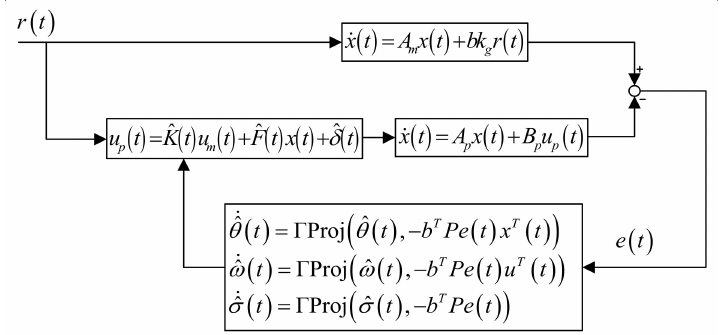
Figure 3. Closed-loop model reference adaptive controller (MRAC)